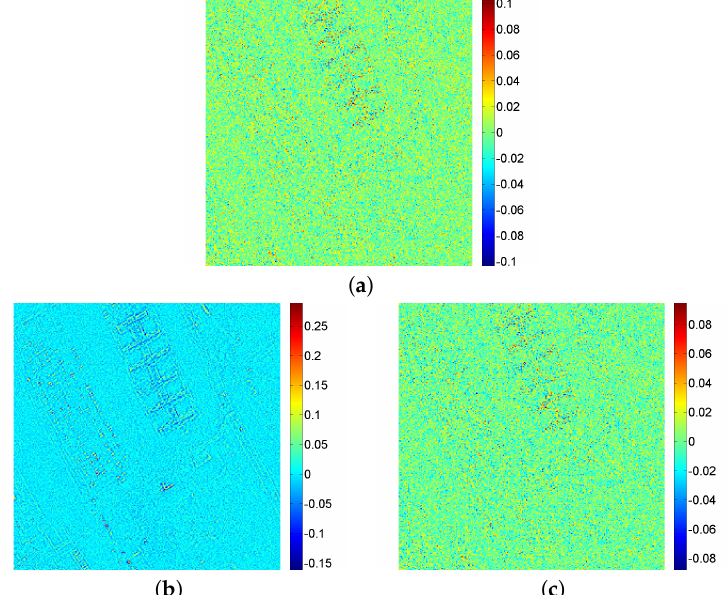
Figure 9. Noise removal using: ( a ) SDNW-MLR; ( b ) SDNW-MWF; ( c ) SDNW-MWPT-MWF, band 10, SNR INPUT = 20